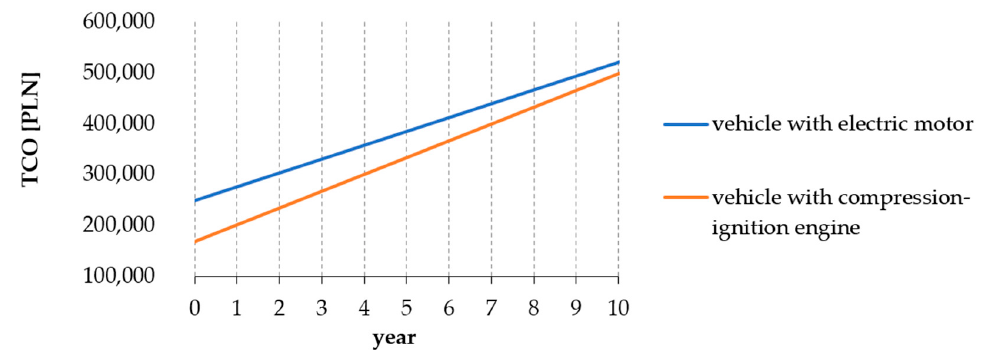
Figure 24. Total cost of ownership of vehicle during the whole operating period—electric vehicle is recharged only at public DC charging stations (the lowest price for 1 kWh was included in the calculations—Scenario B4).